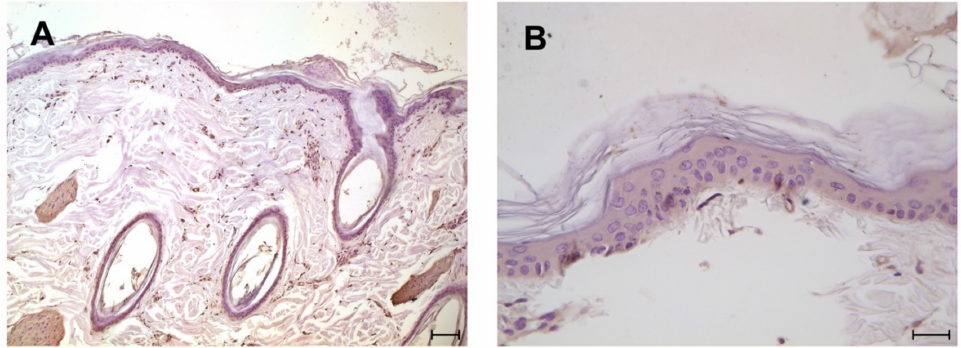
Figure 2. Immunohistochemical analysis for TLR4: normal epidermis with a low and diffuse intensity expression; ( A ) scale bar 75 µ m; ( B ) scale bar 25 µ